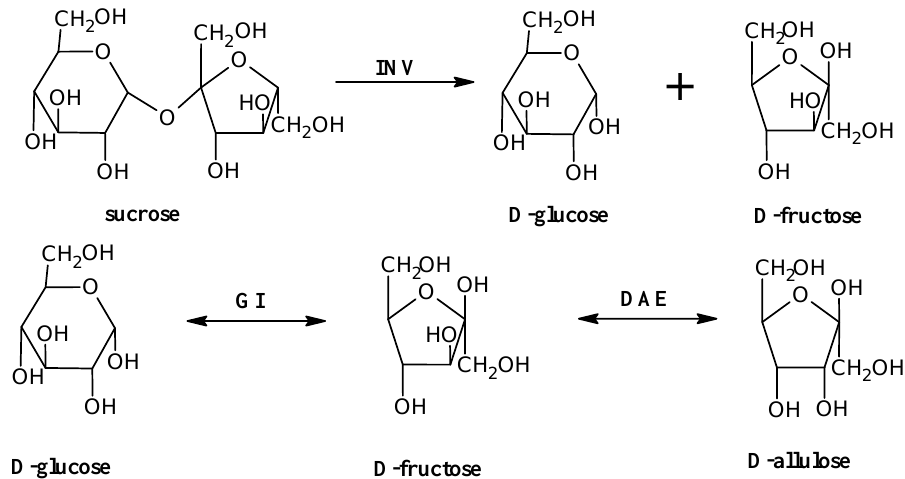
Figure 4. Schematic diagram of the multi-enzyme cascade reaction using INV (invertase), GI (glucose isomerase), and DAE (D-allulose-3-epimerase).